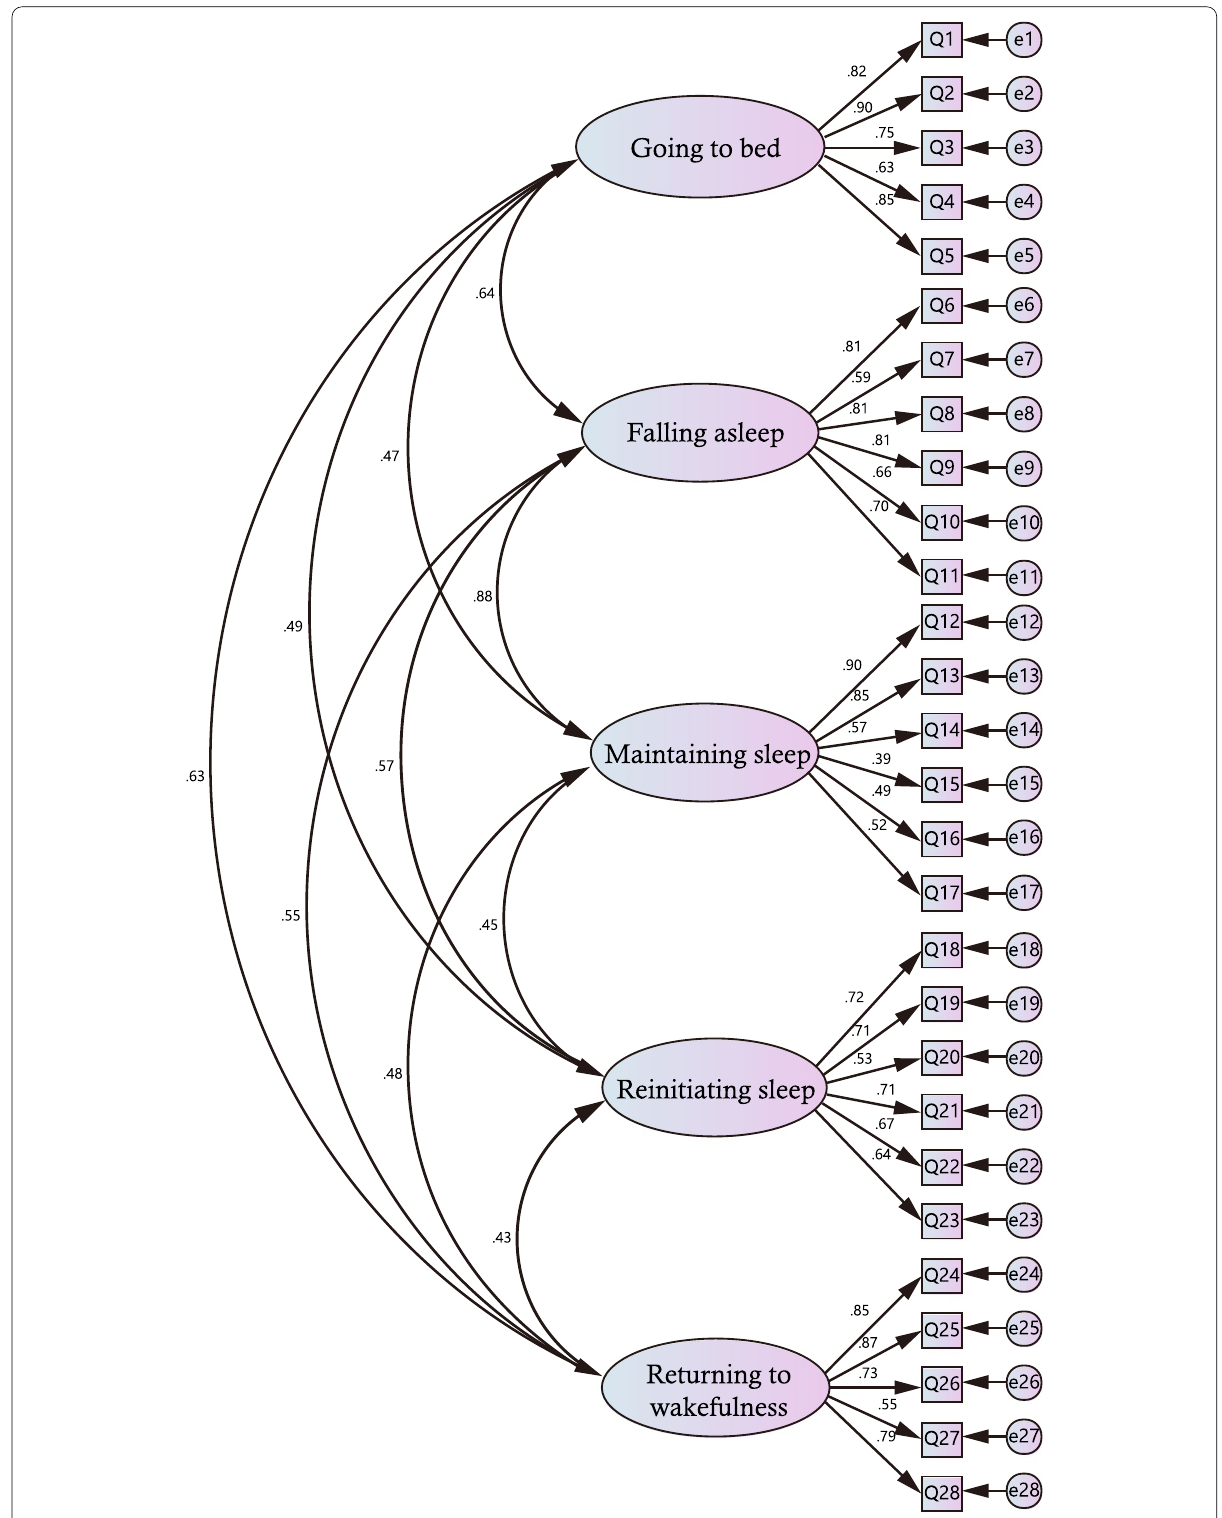
Fig. 1 Confirmatory Factor Analysis of the Chinese Version of